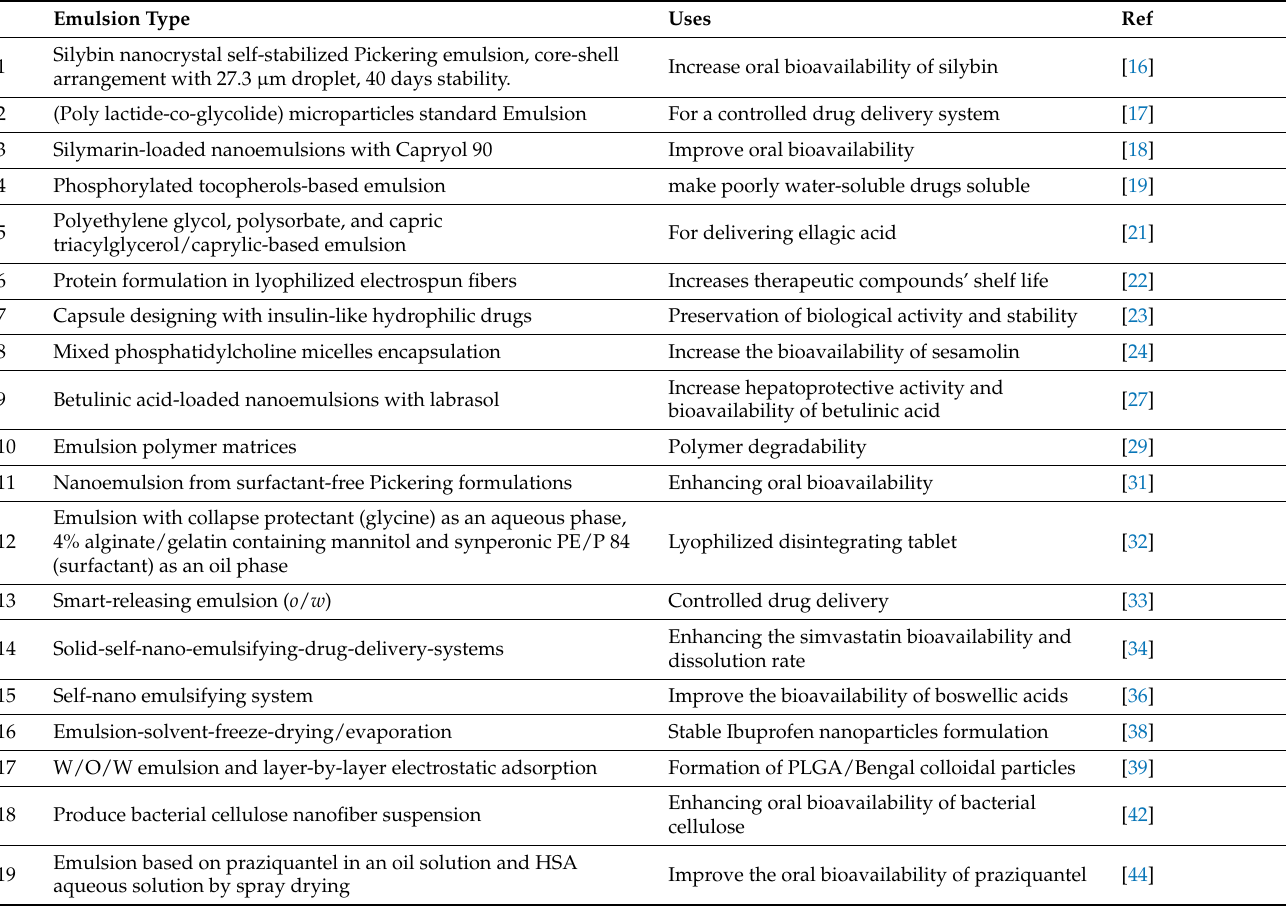
Table 1 summarizes the different types of emulsion formulations and their impacts. Table 1. Different types of emulsion formulation and their